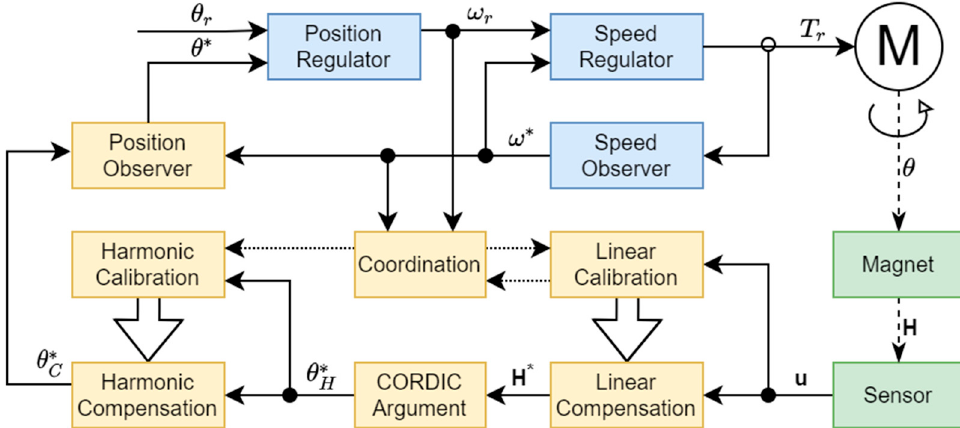
Figure 1. The structure of a servo system with the angular position measurement system.